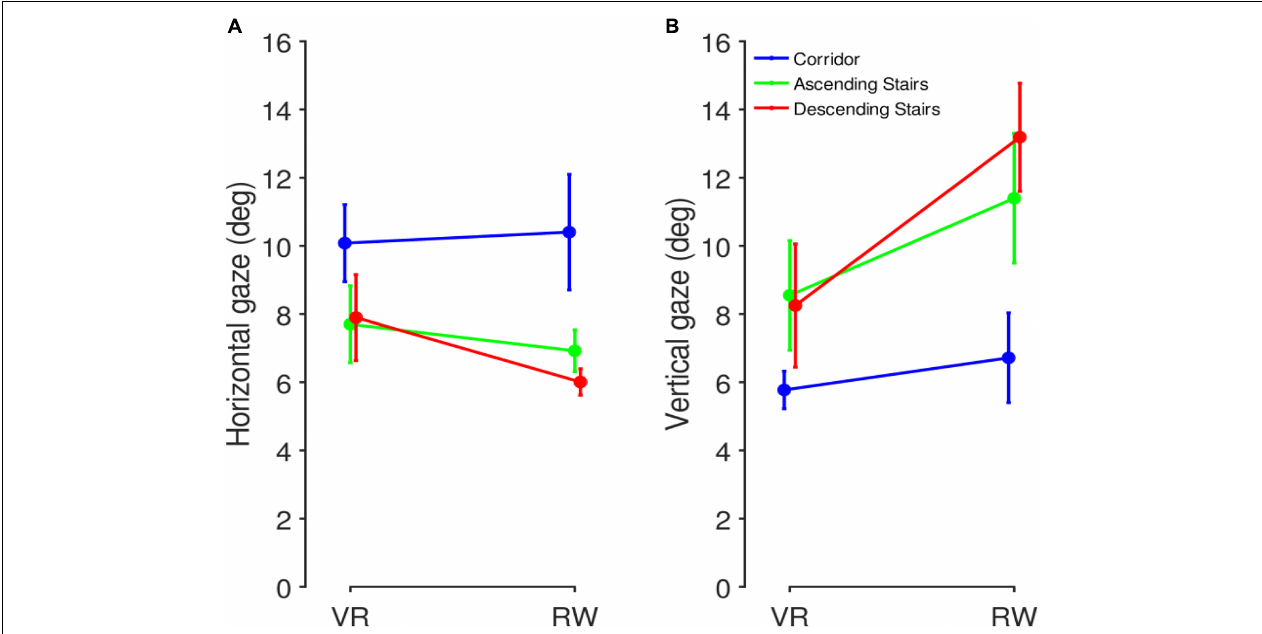
FIGURE 6 | Inter-quartile-range (IQR) comparison between RW and VR. IQRs were computed as a measure of gaze spread, separately for the three sector types. (A) Horizontal gaze IQR. (B) Vertical gaze IQR. Mean and SEM across participants.